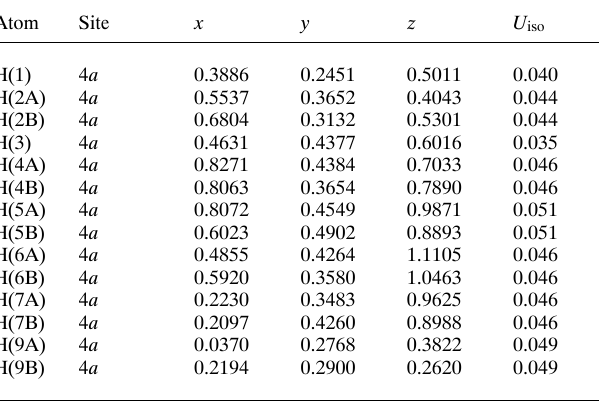
Table 2. A tomic coordin a tes a nd displ a cement p a r a meters (in Å 2 )